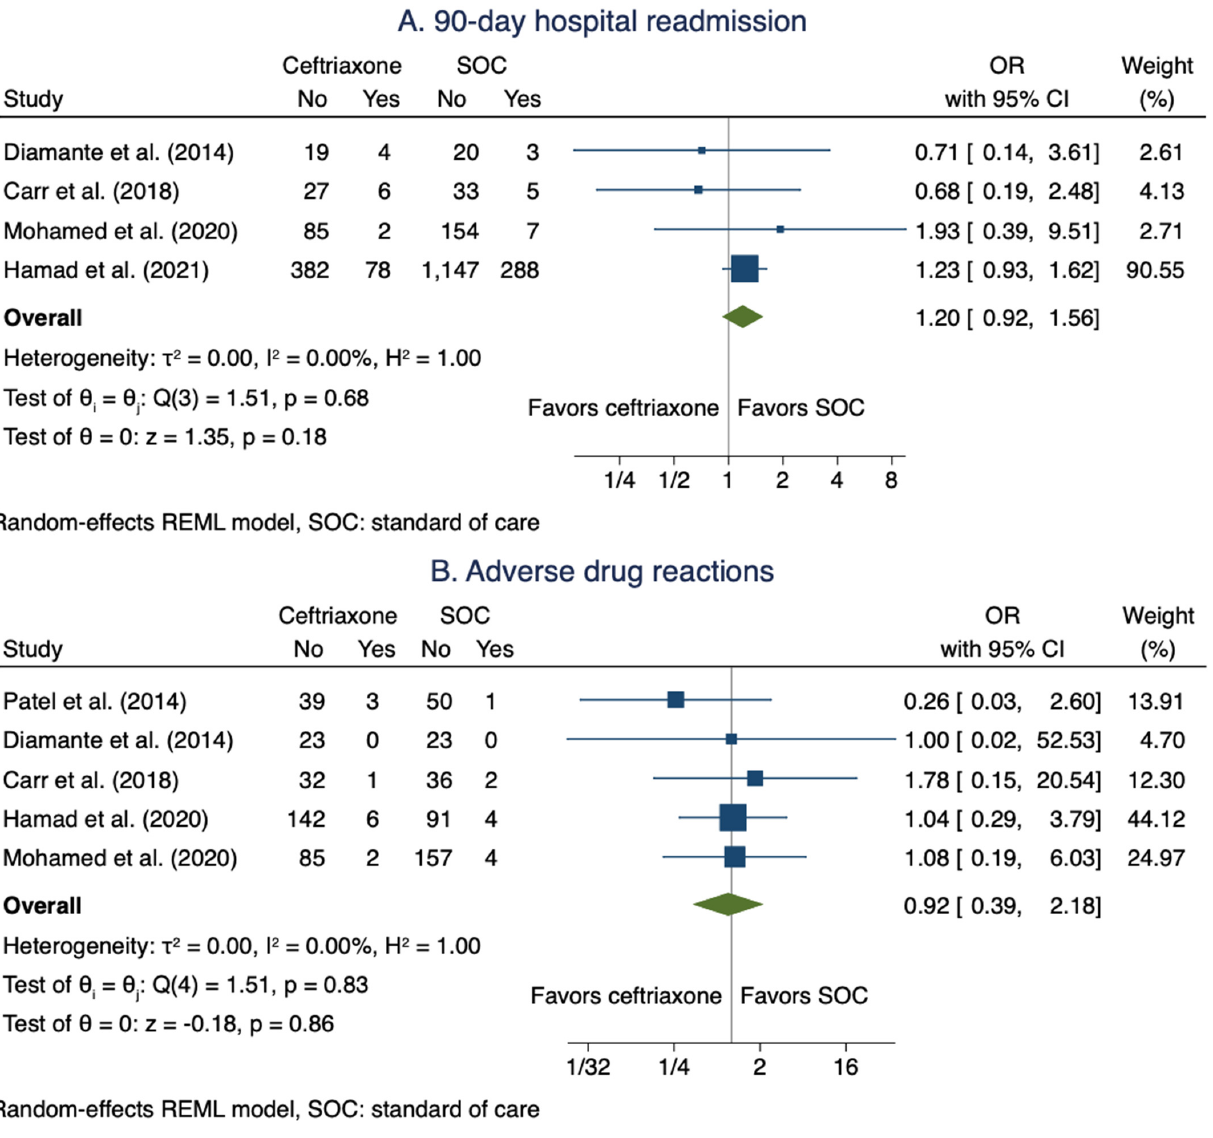
Figure 4. Meta-analysis of 90-day hospital readmission ( A ) and ADRs ( B ).